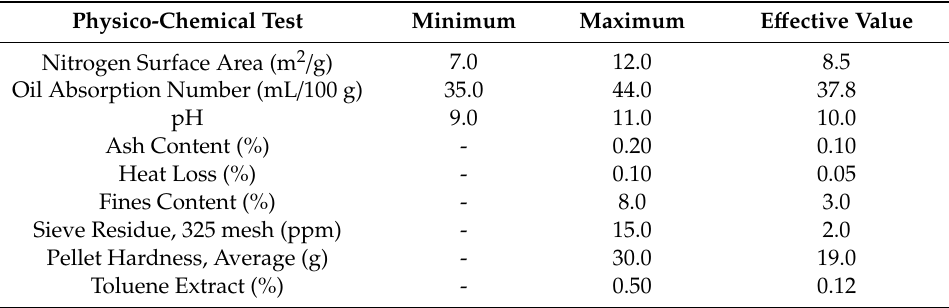
Table 10. Characteristics of thermal black TB Thermax ® N990.